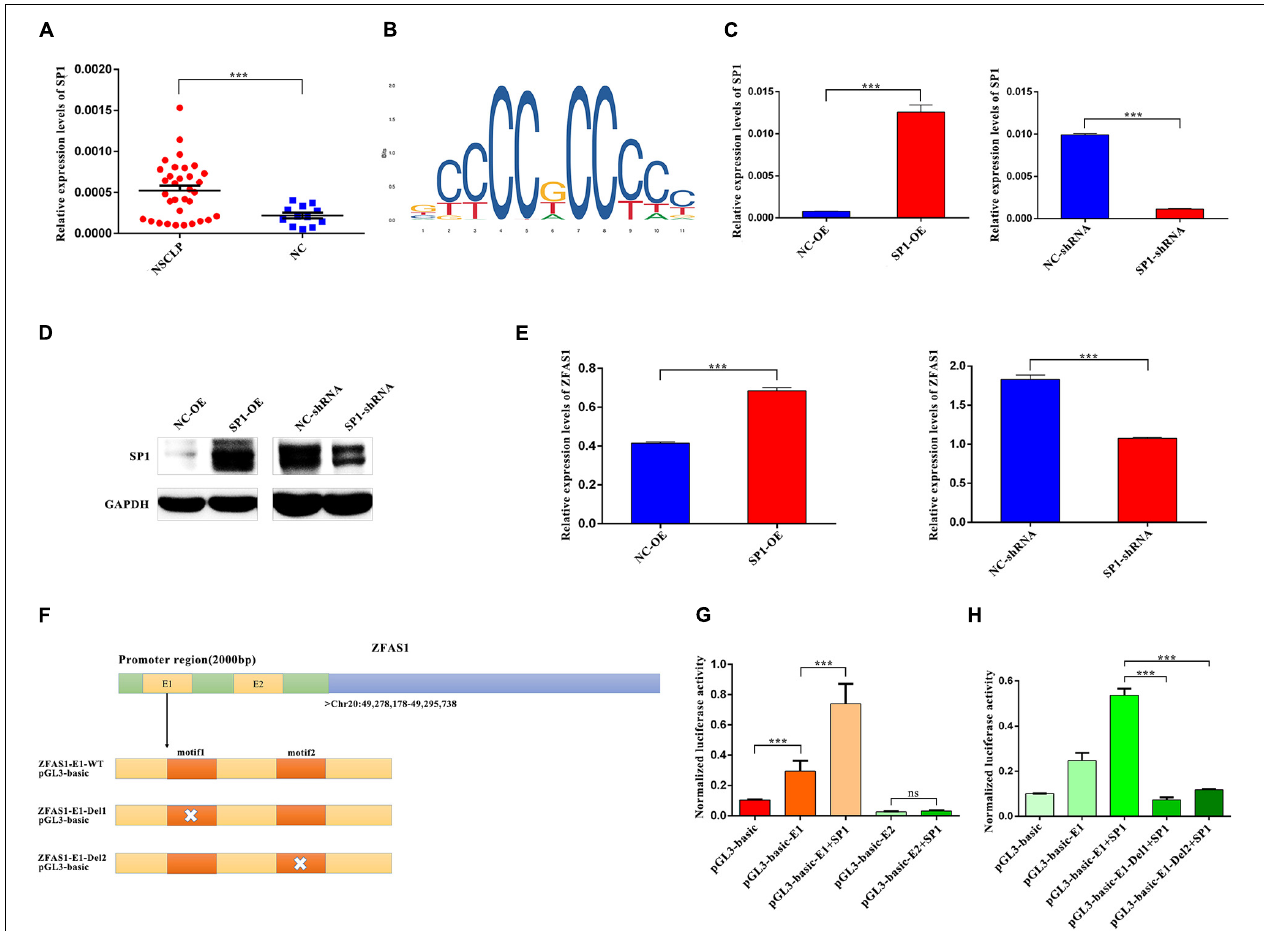
FIGURE 7 | SP1 regulated expression levels of ZFAS1 via binding to the E1 region in the promoter of ZFAS1. (A) SP1 was upregulated in tissues from non-syndromic cleft lip and palate (NSCLP) compared with NC tissues by qPCR assay. (B) The annotated DNA binding motif of ZFAS1 promoter with SP1 in JASPAR database. (C,D) The qPCR and western blotting (WB) assays revealed that SP1 was significantly upregulated and downregulated in human oral keratinocyte (HOK) cells. (E) SP1 positively regulated expression levels of ZFAS1 by qPCR assay. (F) The schema of ZFAS1 for the construction of luciferase reporter plasmids. The orange regions indicate the motif of E1 region in the promoter of ZFAS1; the white cross indicates the deletion of the motif. (G) Dual luciferase reporter assay revealed that SP1 significantly increased ZFAS1 promoter activity via binding to E1 region instead of E2 region. Compared with the “pGL3-basic-E1” group, the “SP1+pGL3-basic-E1” group showed a higher luciferase activity. (H) Dual luciferase reporter assays revealed that deletion of motif1/motif2 in E1 region destroyed the binding of SP1 and E1 region. Compared with the “pGL3-basic-E1 group+SP1 group,” both the “pGL3-basic-E1-Del1+SP1” group